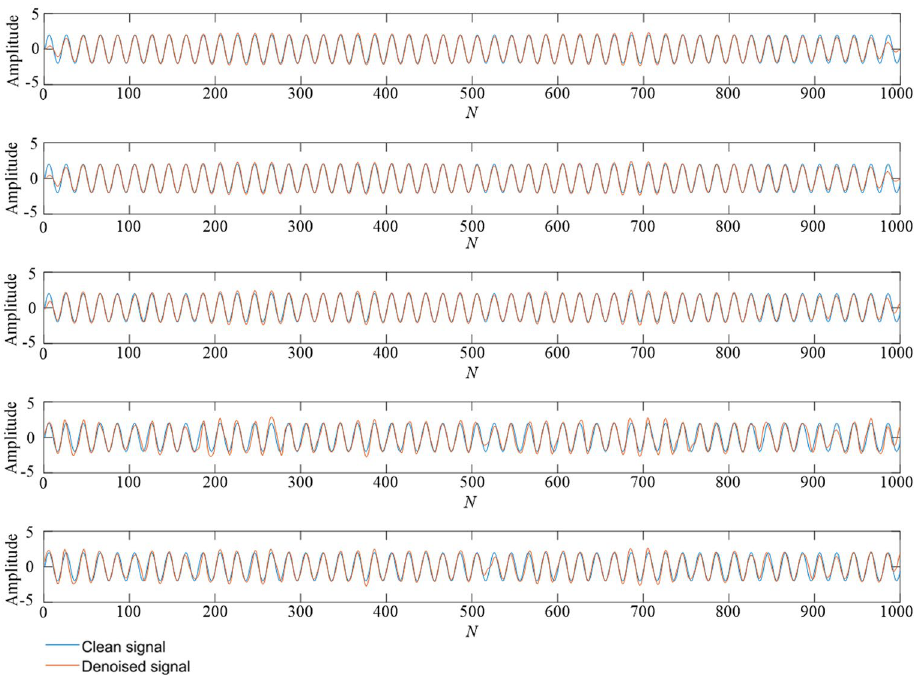
Figure 5. A comparison of denoising effect under 0 dB. From top to bottom: ( 1 ) TS-WOA-VMD-CA-WT; ( 2 ) WOA-VMD-CA-WT; ( 3 ) TS-VMD-CA-WT; ( 4 ) EMD-CA-WT; ( 5 ) EEMD-CA-WT.